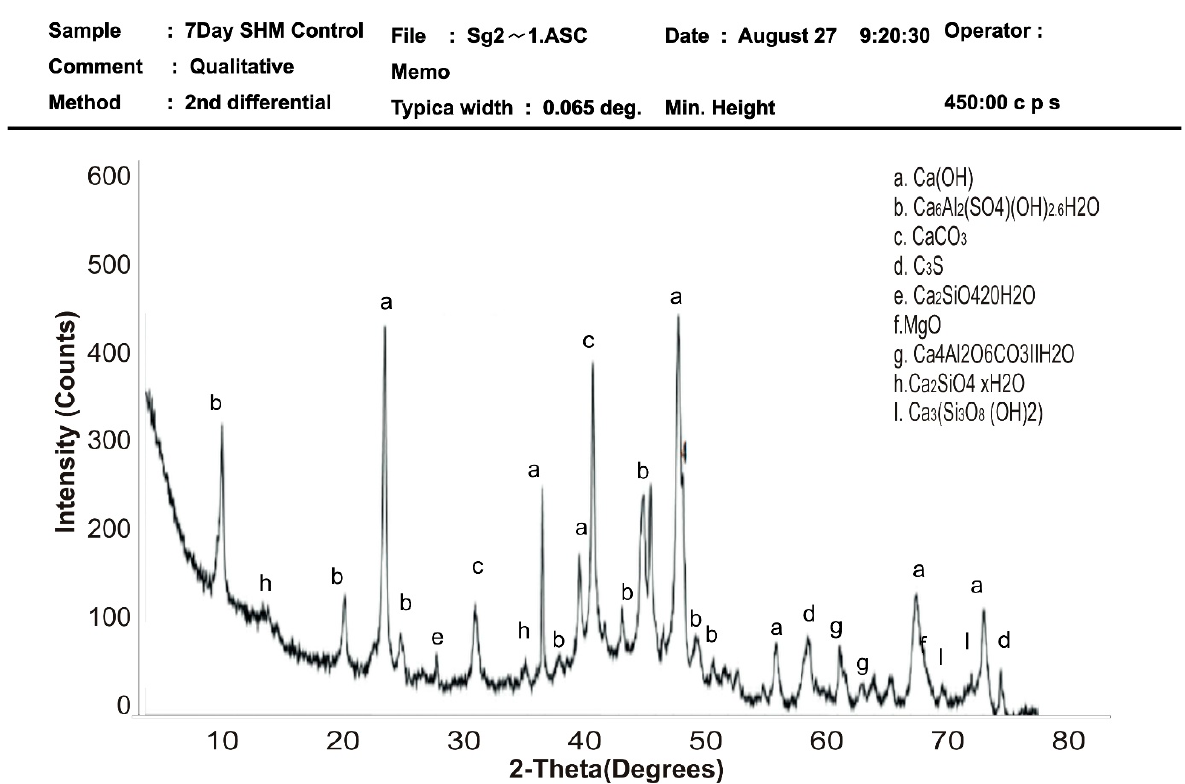
Figure 10. XRD pattern of the hardened control mortar sample at 7 days.